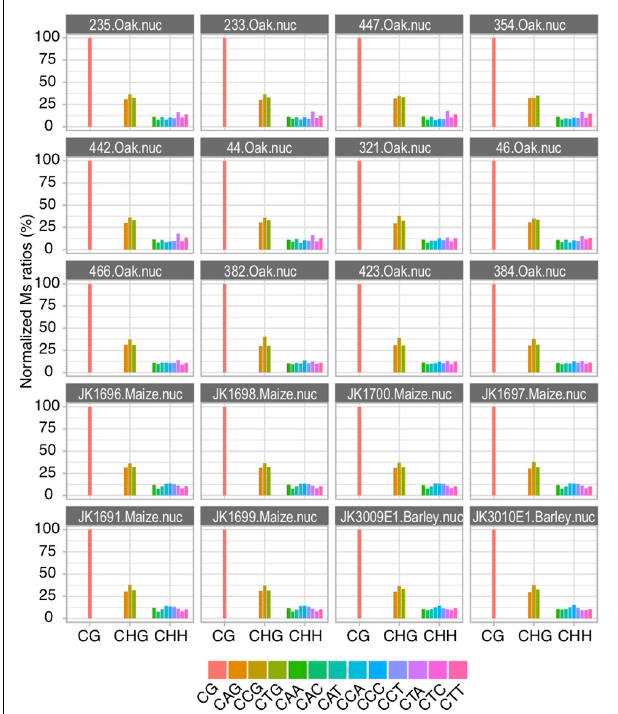
FIGURE 4 | Relative contribution of individual tri-nucleotide sequences to methylation in CHG and CHH contexts. Normalized Ms ratios scored for full read length are shown for nuclear DNA analyzed from sequencing data generated based upon USER-treated